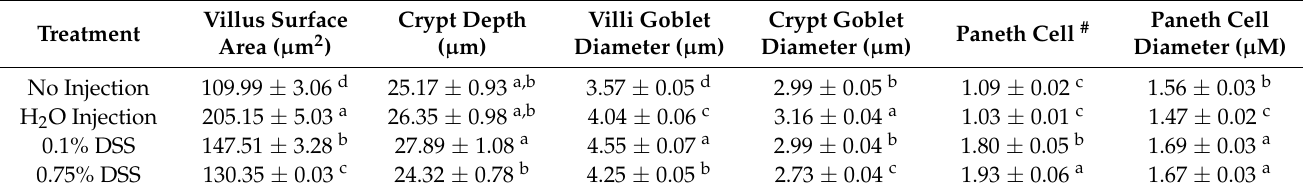
Table 5. Effects on intestinal villi and crypts of the duodenum after the intra-amniotic administration of experimental DSS.